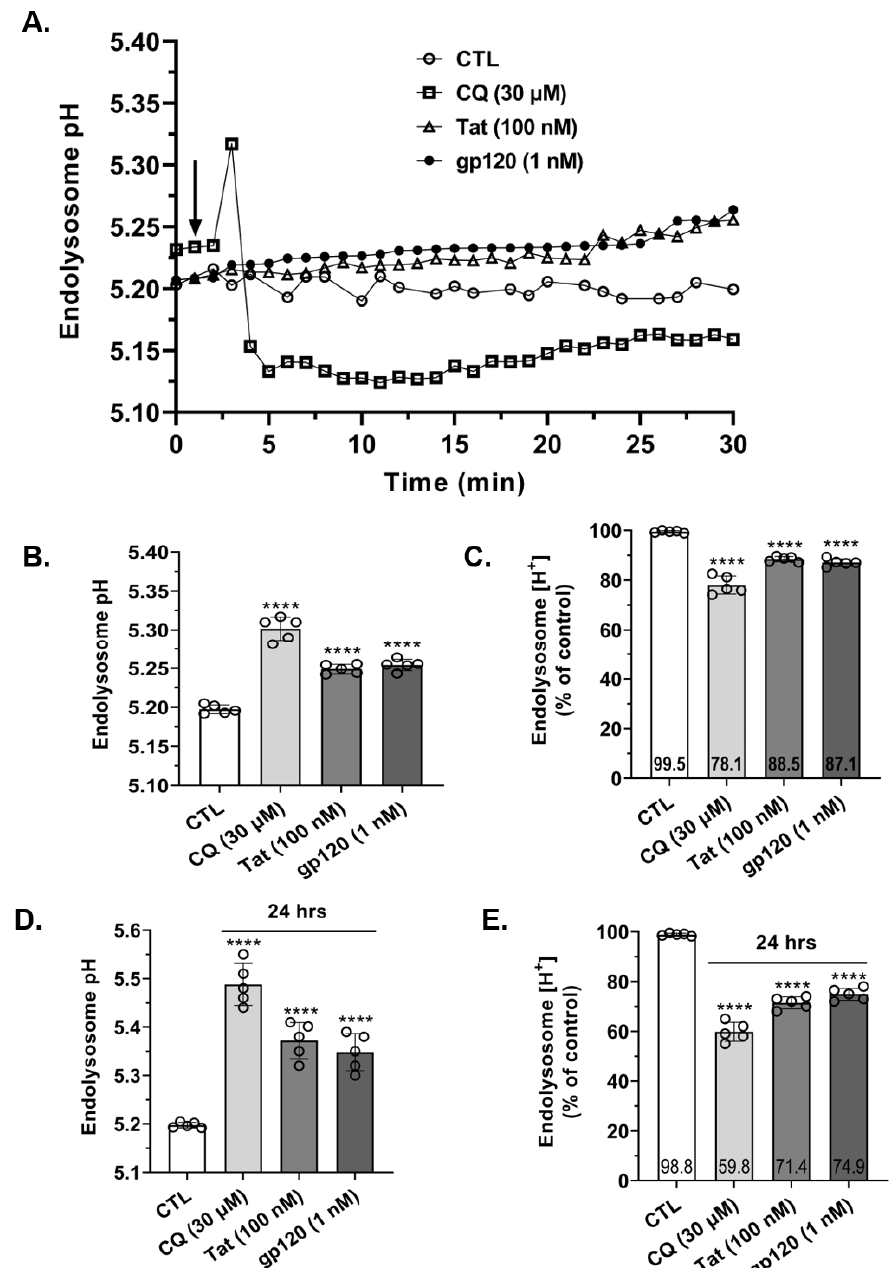
Figure 1. HIV-1 Tat, gp120, and CQ de-acidified endolysosomes. ( A , B ) Treatment of cells with CQ (30 µ M), Tat (100 nM), and gp120 (1 nM) significantly ( p < 0.0001) de-acidified endolysosome pH. Endolysosome de-acidification was shown in real time (arrowhead indicates the timepoint when each compound was added) ( A ) and as peak responses within 30 min ( B ). ( C ) Within 30 min, CQ (30 µ M), Tat (100 nM), and gp120 (1 nM) significantly ( p < 0.0001) decreased the H + concentration of endolysosomes compared to controls. ( D ) At 24 h, CQ (30 µ M), Tat (100 nM), and gp120 (1 nM) significantly ( p < 0.0001) de-acidified endolysosome pH and ( E ) decreased [H + ]. A one-way ANOVA with a Tukey’s post hoc multiple comparisons test was used for analysis. Each data point represents the mean pH measurement of 50 endolysosomes from five cells performed independently five times for each group ( n = 250). Cells were chosen randomly in the microscope’s field of view with 25 cells used for experimentation per group; no cells were intentionally excluded. **** p < 0.0001 .